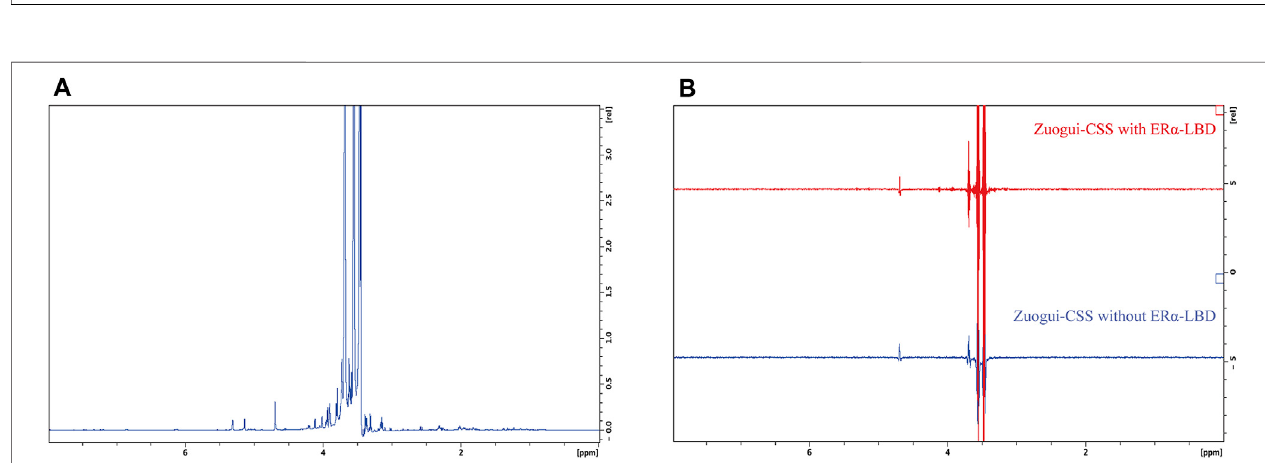
FIGURE 8 | STD NMR detection for estrogenic compounds in Zuogui-CSS. (A) The 1D 1 H NMR spectrum of Zuogui-CSS. (B) The STD spectra of Zuogui-CSS in the presence of ER α -LBD (upper red spectrum) and in the absence of ER α -LBD (lower blue spectrum). Only nonspeci fi c solvent signals from glycerol (3.54, 3.63, and 3.77 ppm) and H 2 O (4.70 ppm) were observed in the STD spectra.